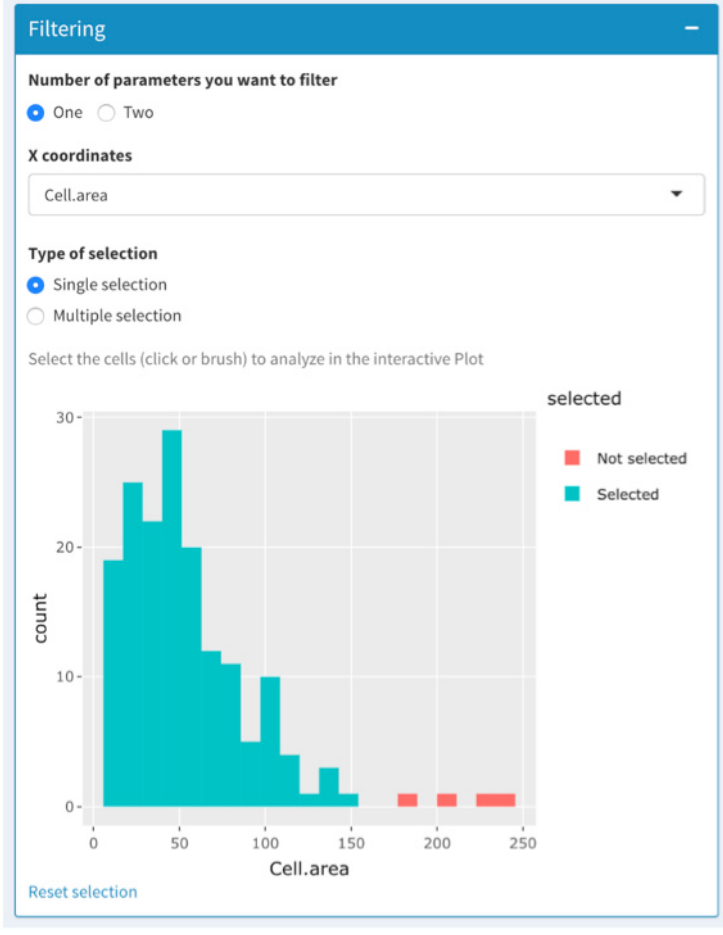
Figure 2. Menu “Plot to Image” of SAPHIR application. The data-filtering tab allows the selection of cells to be analyzed based on one or two parameters. Based on the cell area parameter, only cells that displayed a conventional cell area (in blue) were selected. Badly segmented cells (large area in red) were